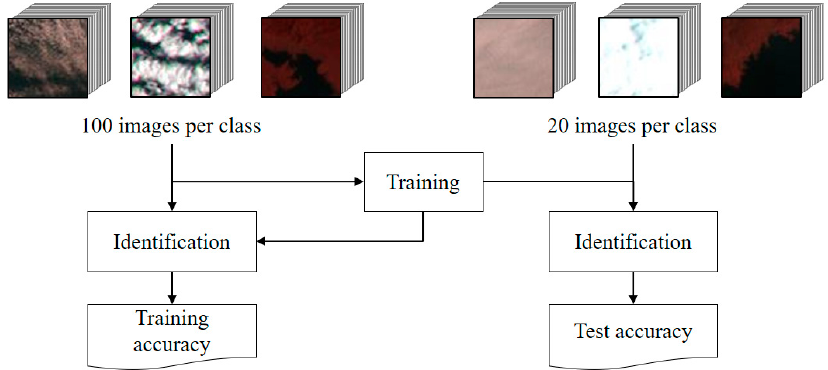
Figure 4. Difference between training accuracy and test accuracy. Training accuracy means that identical images are used both for training and testing, while test accuracy represents that the trained model identifies independent images that were not used in training.